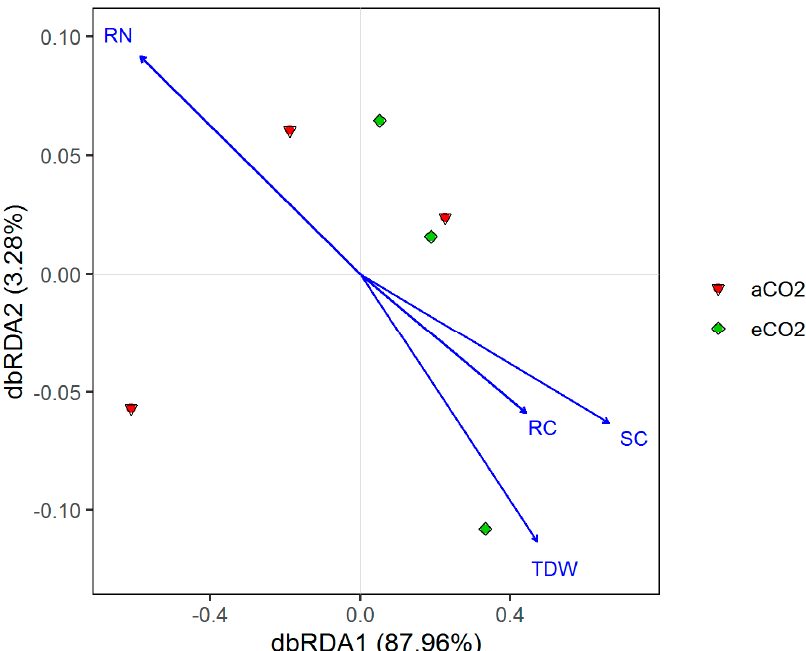
Figure 7. Distance-based redundancy analysis (dbRDA) of functional genes with plant characteristics as explanatory variables under aCO 2 and eCO 2 . Only the first axis was significant with an explained variation of 87.96% ( p = 0.0361) and the permutation value of the overall model was 0.0361.